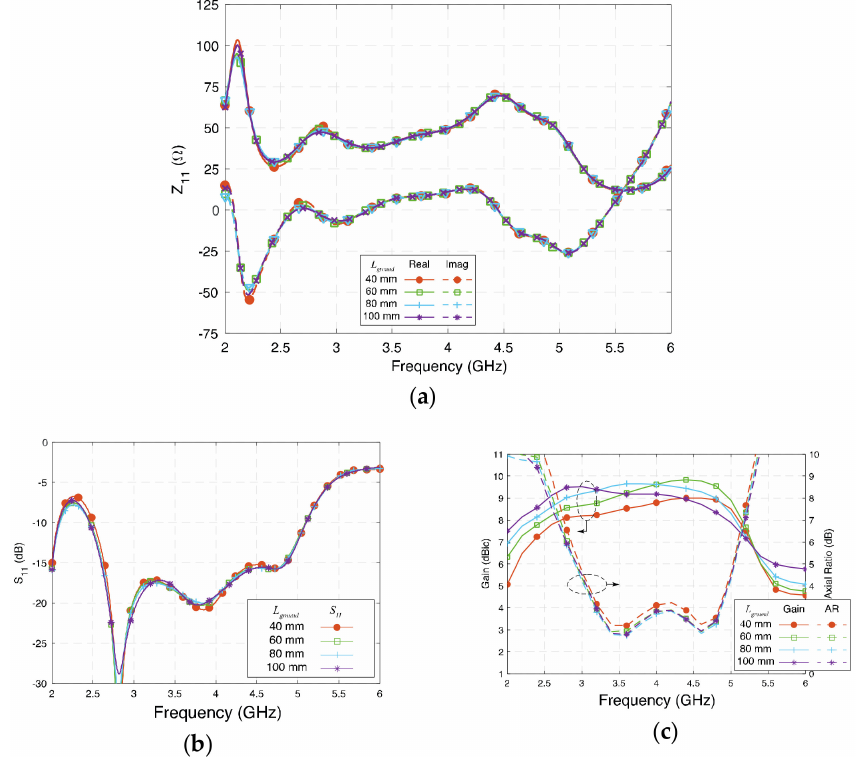
Figure 10. ( a ) Impedance (Z 11 ) , ( b ) reflection coefficient (S 11 ), and ( c ) gain and axial ratio of the proposed antenna at different L ground